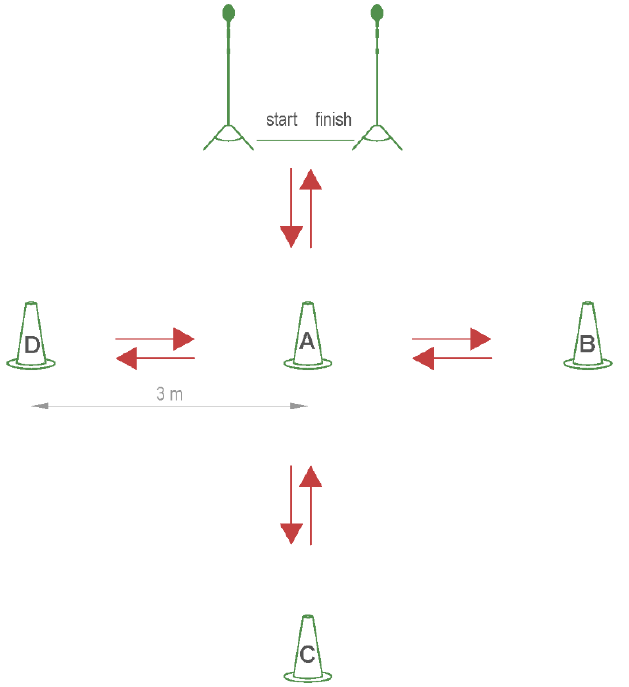
Figure 9. Compass Drill. The running path of the test forms a star. The participant has to run along the trajectory and touch the cones. Adapted and edited from [18] .